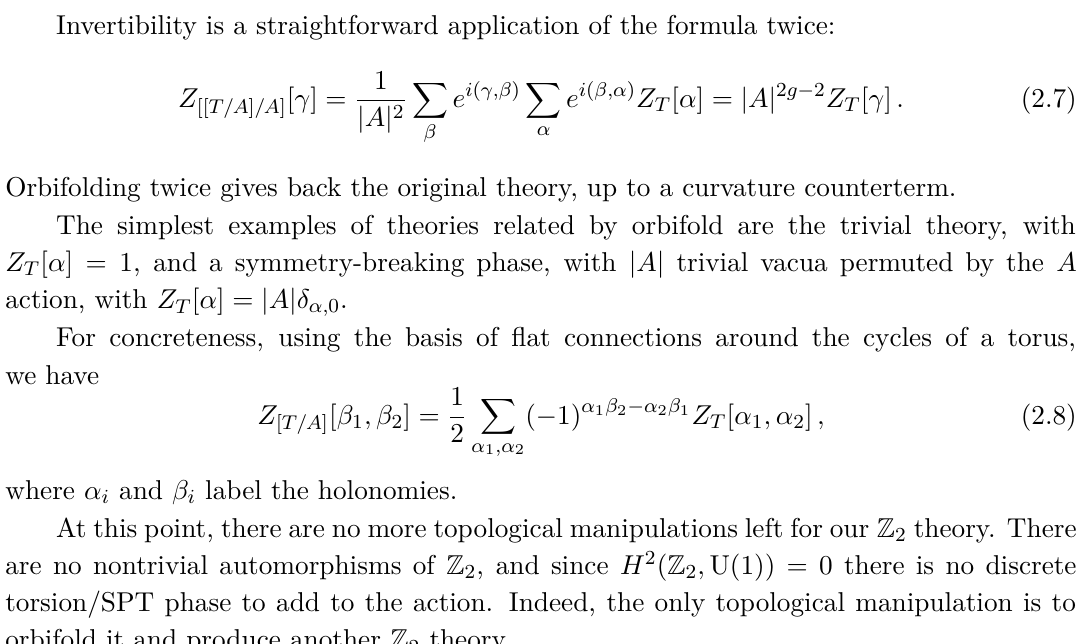
Figure 5 . For any theory with non-anomalous finite Abelian A symmetry, we obtain a new theory with ˆ A ∼ = A symmetry by gauging all of A . These correspond to the Dirichlet and “entirely- Neumann” boundary conditions for the associated DW[ A ] . In the case of a non-anomalous A = Z ( p prime) this is the complete orbifold groupoid (suppressing multi-edges and edges from a vertex to itself), as there are only two bosonic irreducible topological boundary